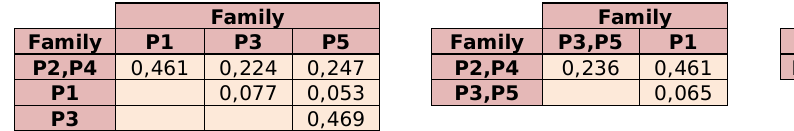
Table 4. Similarity coefficients for successive grouping steps